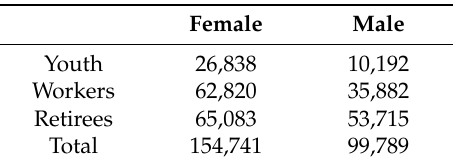
Table 2. ENDE (Elite New Dehli English) age/gender stratified sub-corpus sizes. Youth are aged 18–22, Workers are aged 27–52, Retirees are aged 62–87. Because this data was collected for other purposes, the sub-corpora are not balanced in